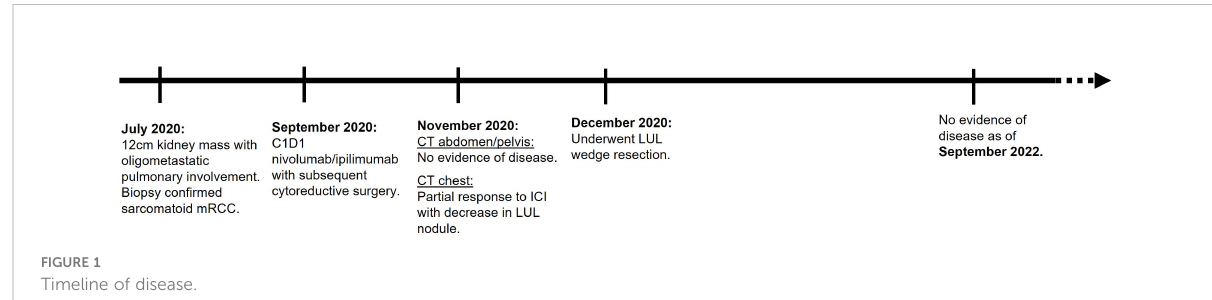
FIGURE 1 Timeline of